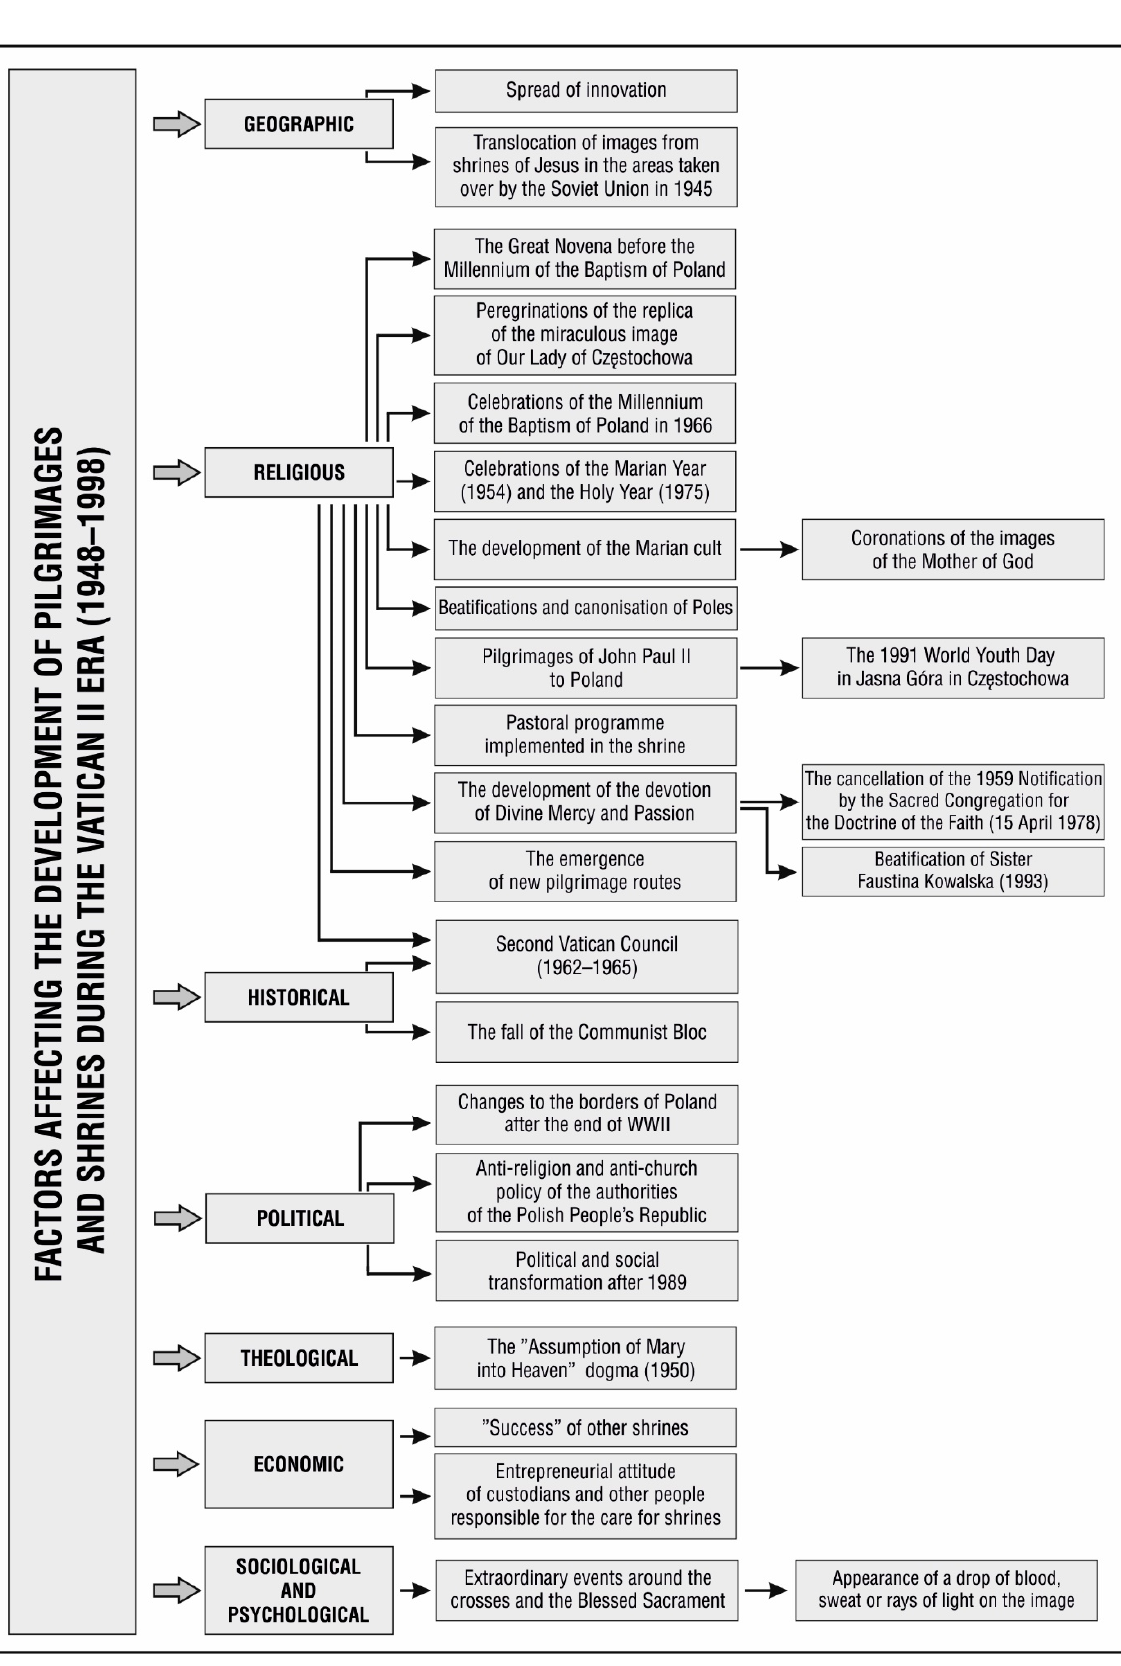
Figure 1. Factors affecting the development of pilgrimages and shrines during the Vatican II era (c. 1948–1998). Source: author.